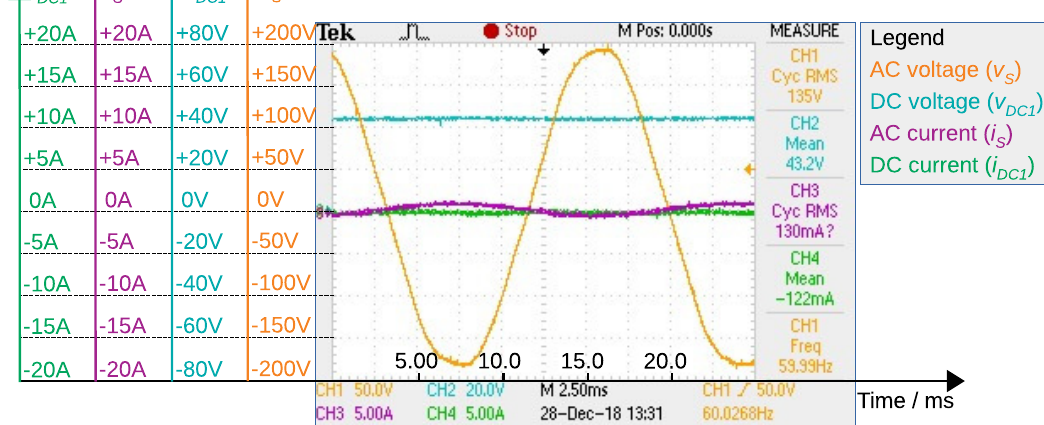
Figure 17. Measurements at 13:31 (of day 2)—Converter charging the batteries (stage